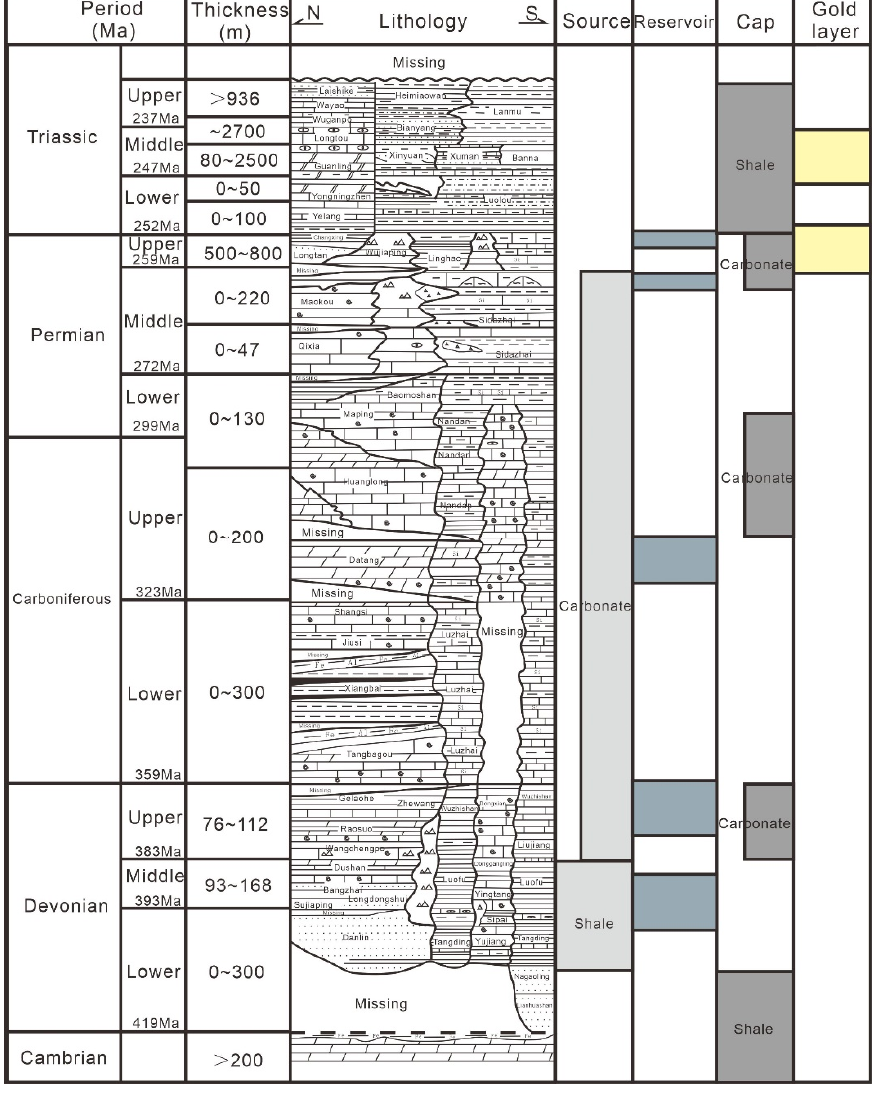
Figure 2. Comprehensive stratigraphic column of the Nanpanjiang-Youjiang Basin [13]).